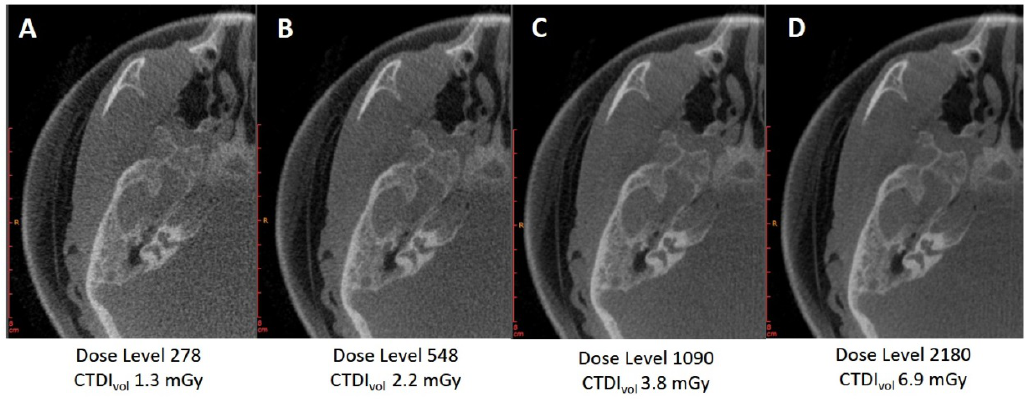
Figure 5. Display of image quality at 121 kV and pre-filtering of X-rays with 0.4 mm tin filter, rising dose levels from ( A – D ). Data sets with tin pre-filtration were rated as insufficient for preoperative imaging.